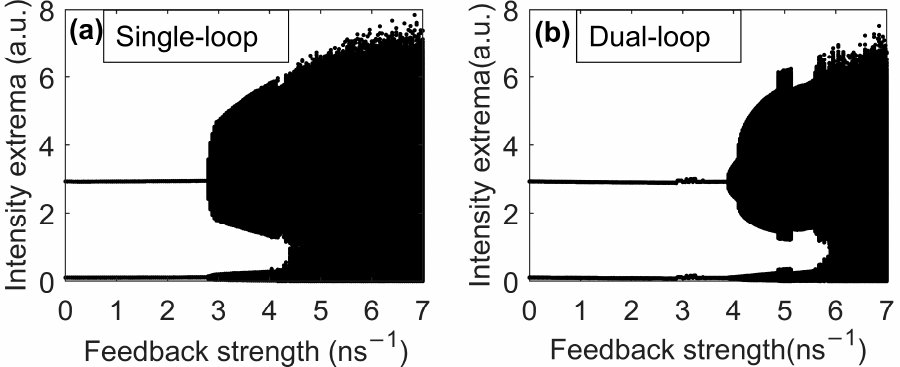
Figure 7. The bifurcation of an optically pumped QD spin-VCSEL subject to ( a ) single-loop feedback and ( b ) dual-loop feedback. The delay times are fixed at τ = 4 ns for single-loop feedback and ( τ 1 , τ 2 ) = (4 ns, 6.5 ns) for dual-loop feedback.